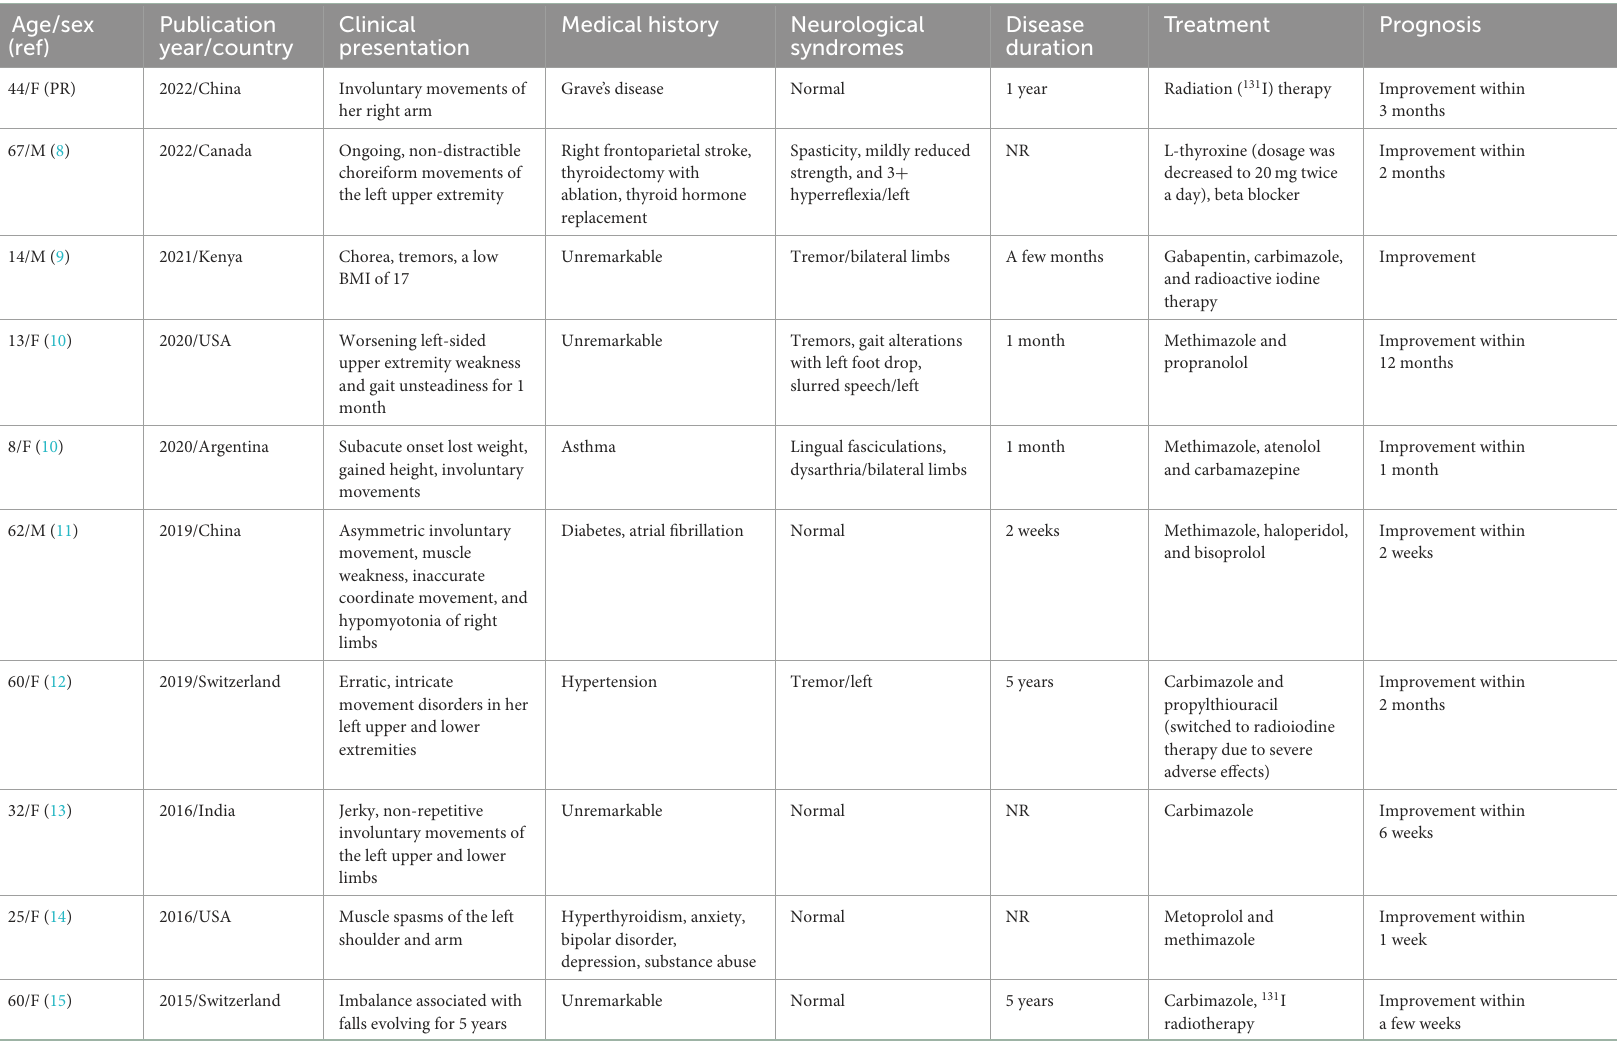
TABLE 1 Clinical characteristics of 28 patients with hyperthyroidism-associated